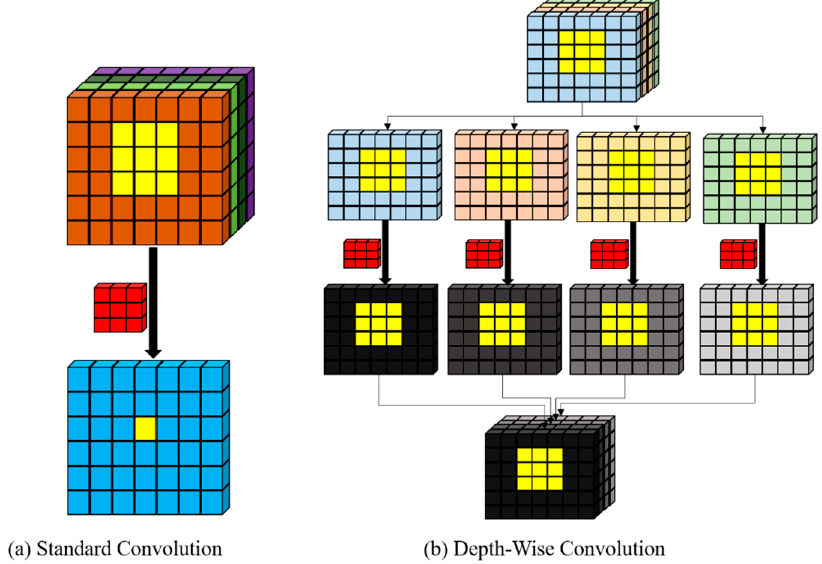
Figure 9. The main difference between standard convolution blocks and depth-wise convolution blocks.